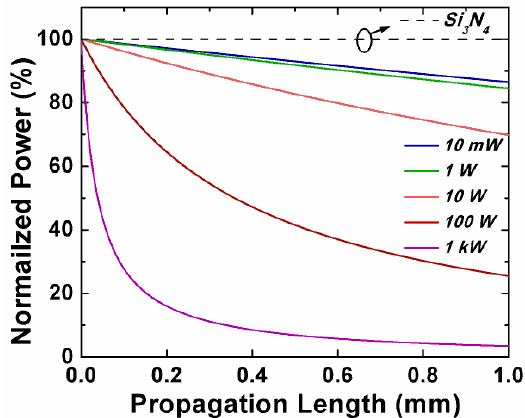
Figure 3. Normalized power of the inputs to the Si and Si 3 N 4 horizontal slot waveguides.